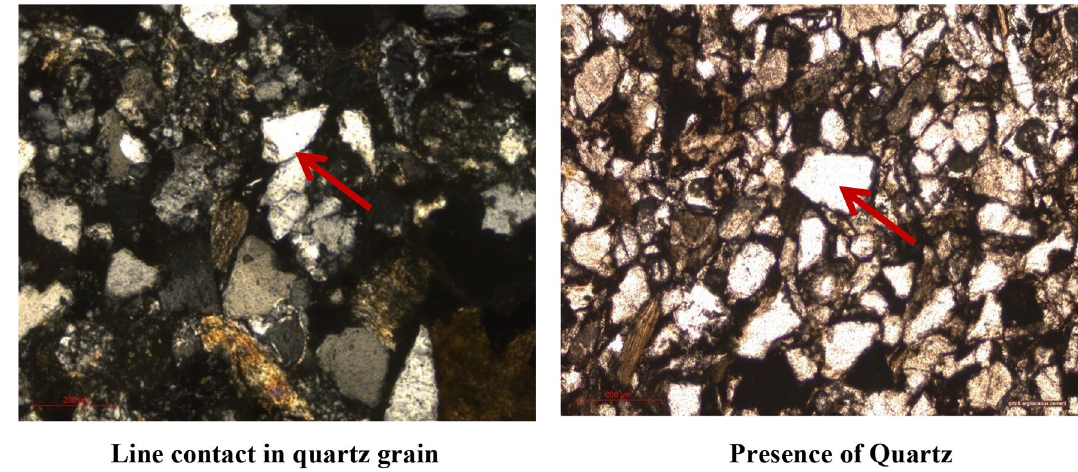
Fig. 3 Thin section images of sandstone showing the presence of Line contact in quartz